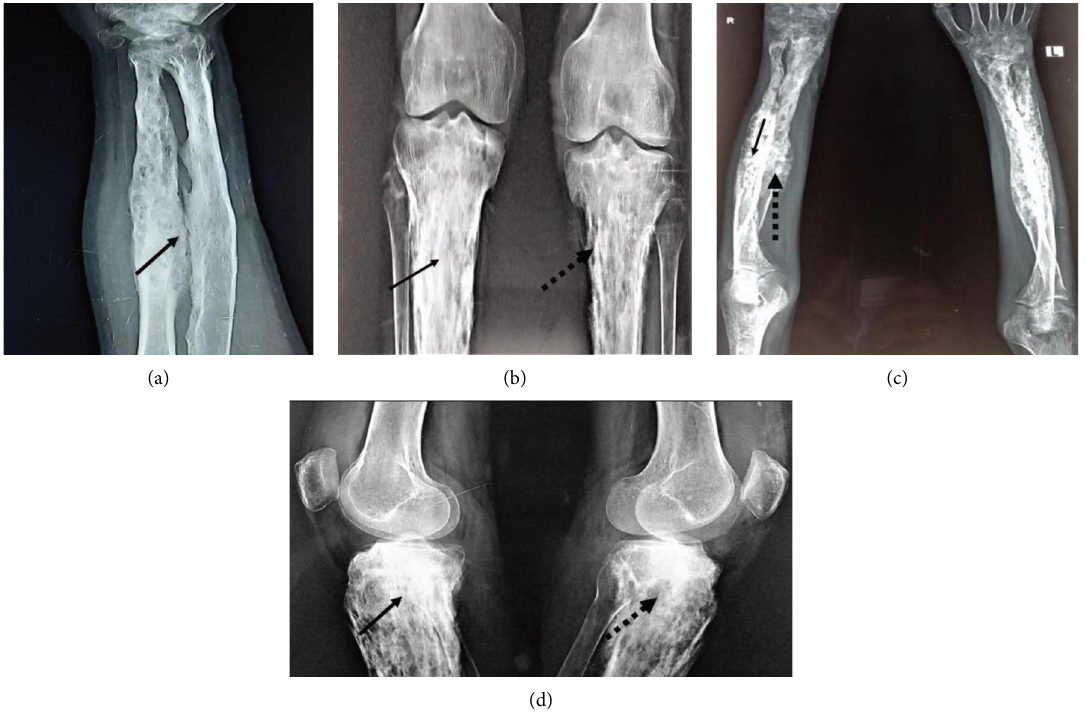
Figure 2: (a) X-ray right forearm (both radius and ulna) showing hyperostosis with few lytic area, (b) X-ray knee (AP) showed bilateral tibia periosteal reaction, hyperostosis, osteolysis with osteopenia, (c) Lytic lesions and hyperostosis increased after 1 year during replace, (d) increased sclerotic lesion, lytic lesion with osteopenia after 1 year during relapse. Plain arrow-sclerotic lesion, dotted arrow-lytic lesion.